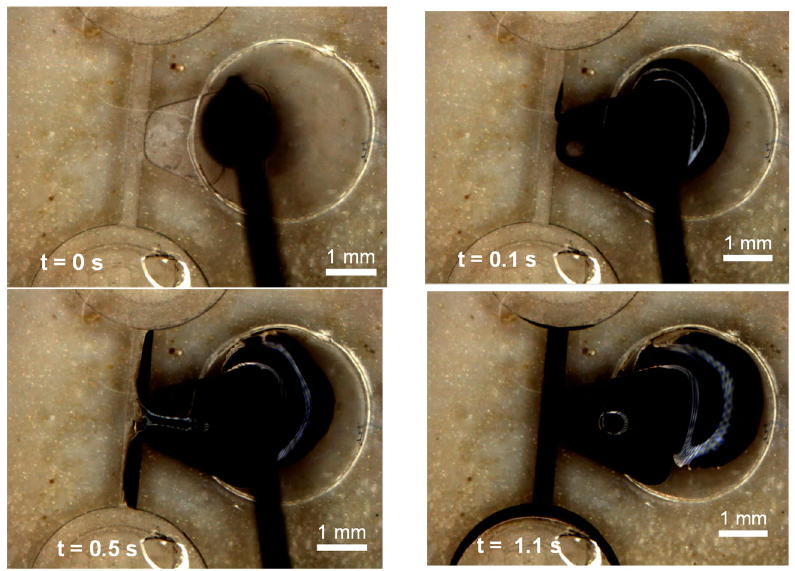
Figure 4. Images (with the corresponding time stamps) showing the deposition (using a heated Hamilton syringe) of the molten ferrowax and its subsequent motion due to the action of the capillary forces and the blocking of the fluidic channel.